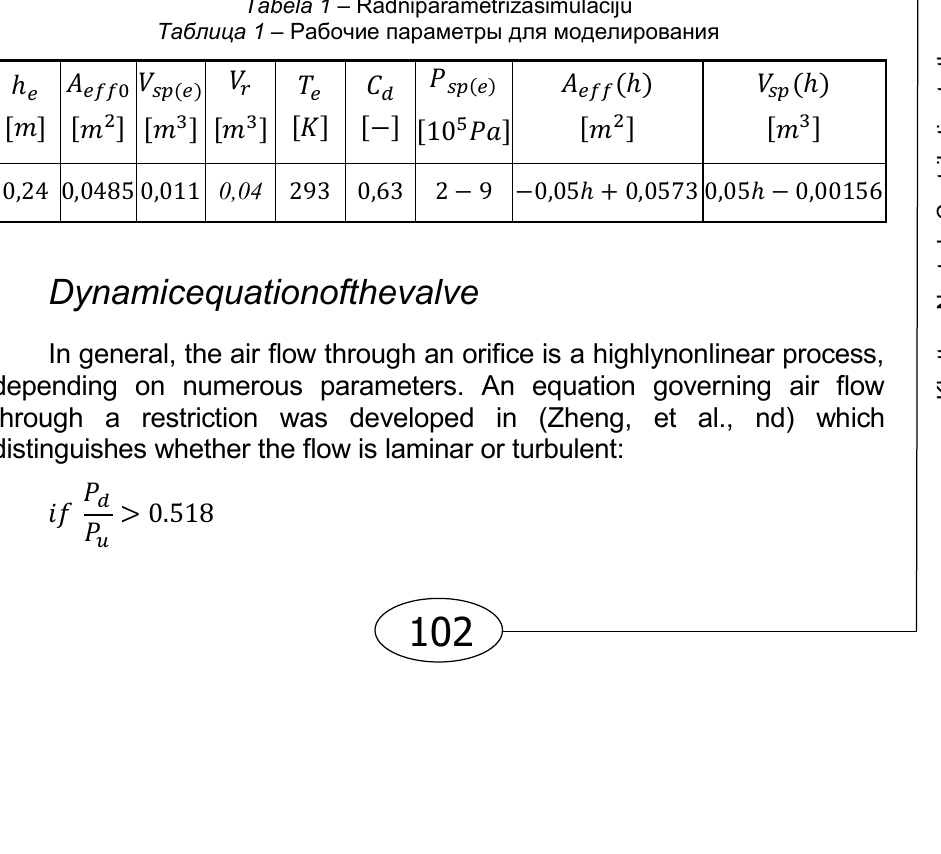
Table 1 – Working parameters for the simulation Tabela 1 –